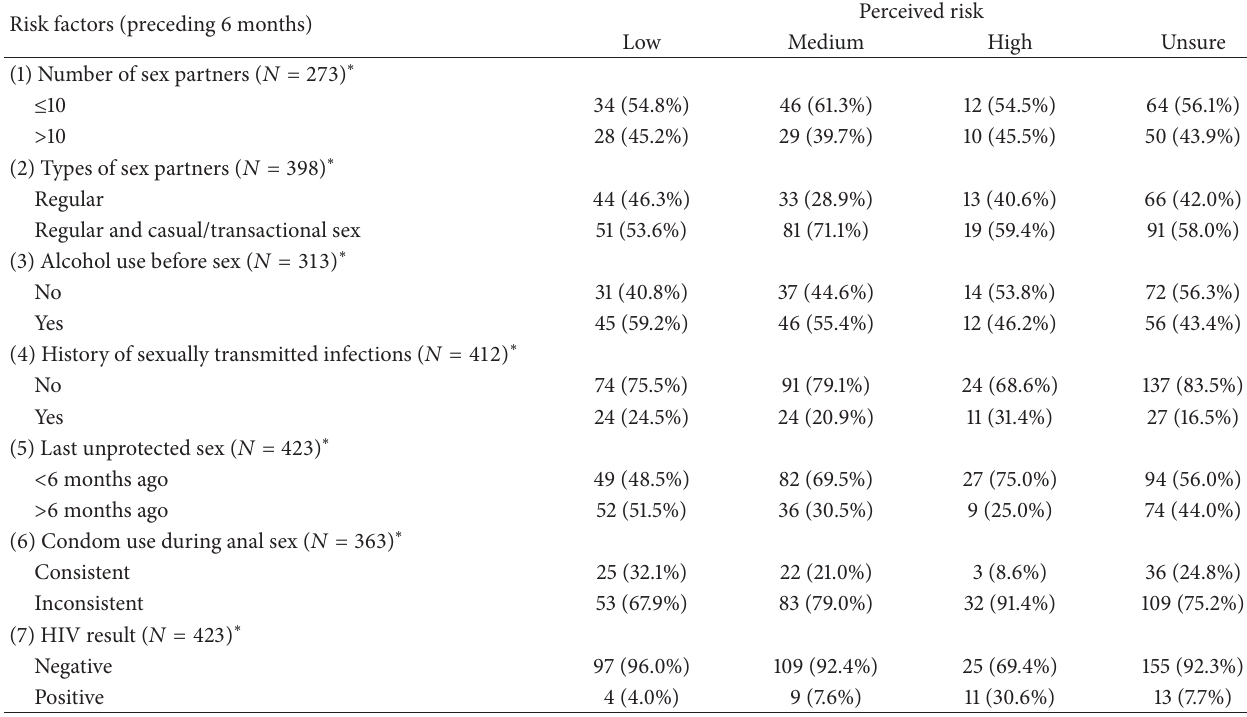
Table 2: Risk factors and prevalence of HIV in each perceived risk group.